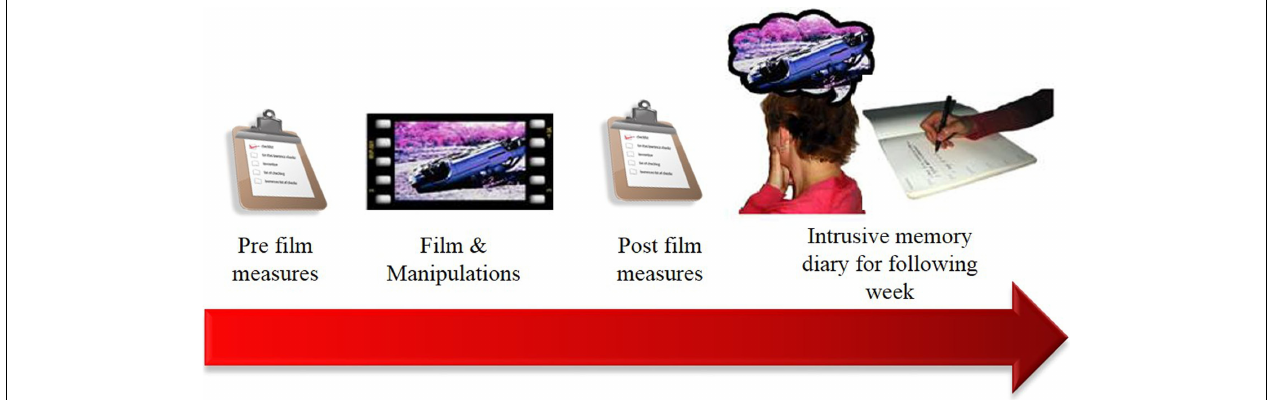
FIGURE 1 | Diagram of the general procedure of the trauma film paradigm . Participants view a distressing film as an analog of a traumatic event. Over the following week they record any intrusive memories of the film in a diary. This allows for investigation of baseline differences affecting intrusive memory development, or tasks that might increase/decrease later intrusive